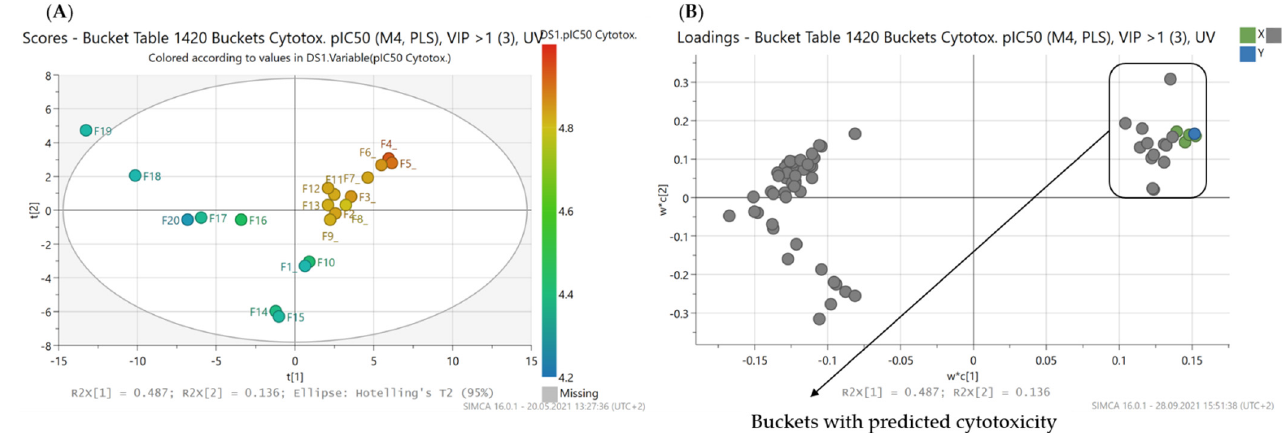
Figure 6. PLS model with a prediction of cytotoxic compounds from B . sempervirens L. ( A ) Scores plot of the second vs. the first PLS component of the PLS model. Coloration indicates the cytotoxicity of the fractions ranging from a pIC 50 value of 4.26 (F20, blue) to a value of 4.94 (F4, red); ( B ) corresponding loadings plot to ( A ). The buckets marked with a box in the upper right quadrant are predicted as compounds mainly responsible for the low overall cytotoxic activity of the B. sempervirens extract (Buckets marked in green are detailed in Figure 7).